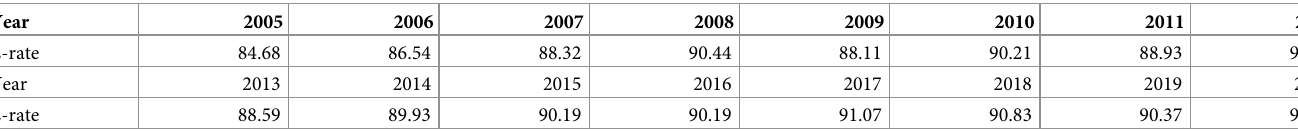
Table 5. Employment rate data of Liren College, Yanshan University from 2005 to 2020.